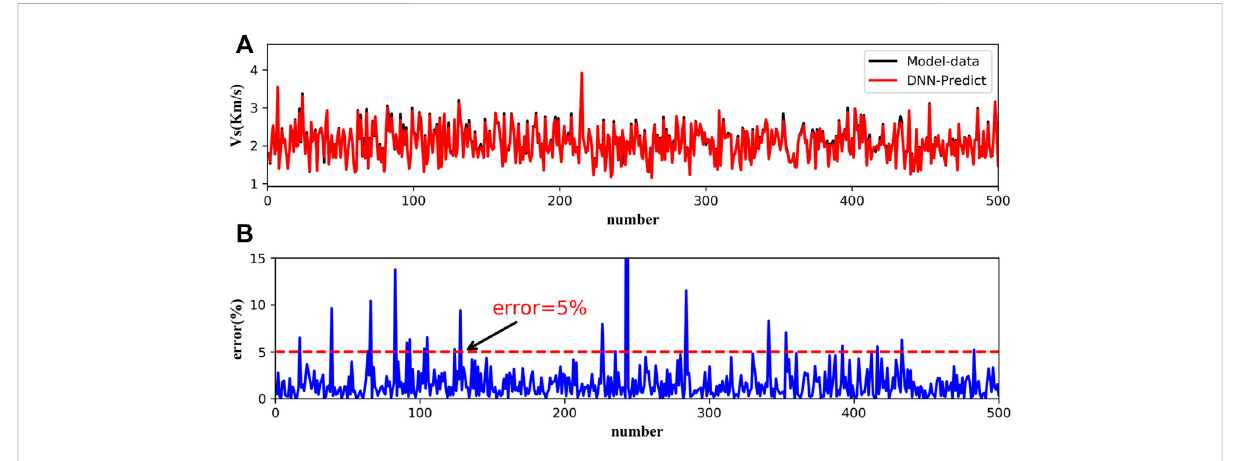
FIGURE 4 Test results of 500 synthetic data. (A) Test results. (B) Relative